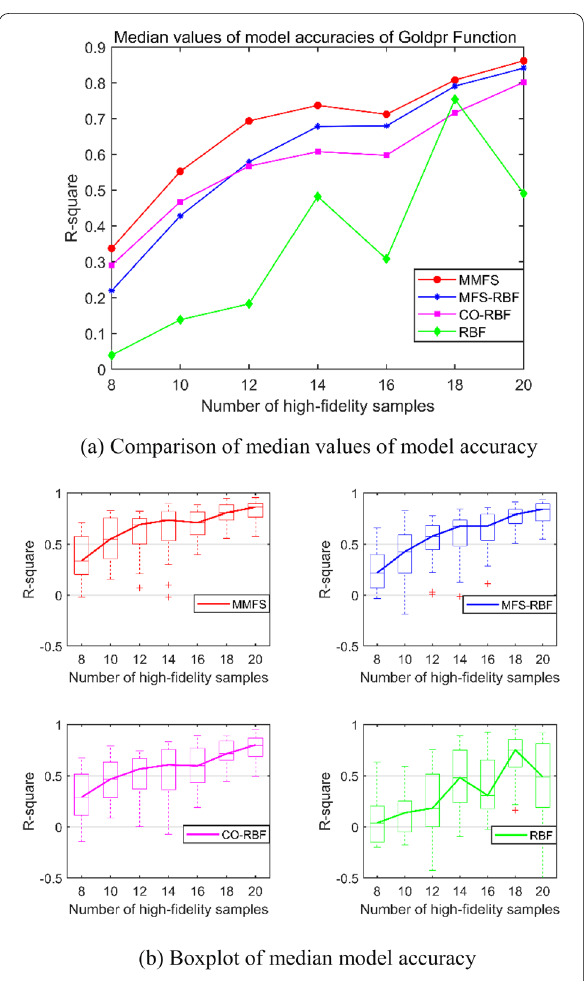
Figure 9 Median values of model accuracy of Goldpr function: a Comparison of median values of model accuracy, b box plot of median model accuracy